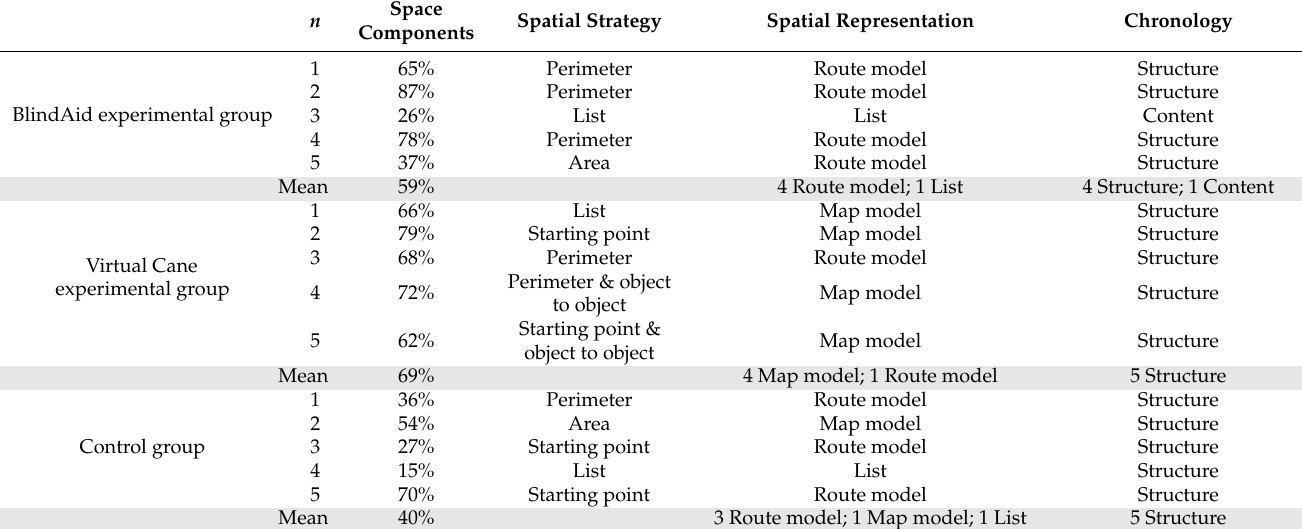
Table 4. Verbal description process of simple